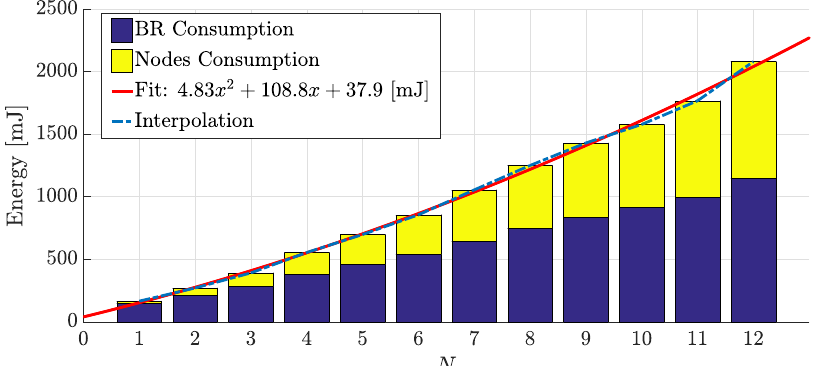
Figure 10. Energy spent by the overall network during the SCR-RES phase with CCR set to 16 Hz (metric EN-SCR-RES). Bars show the amount of energy spent by BR and Nodes.